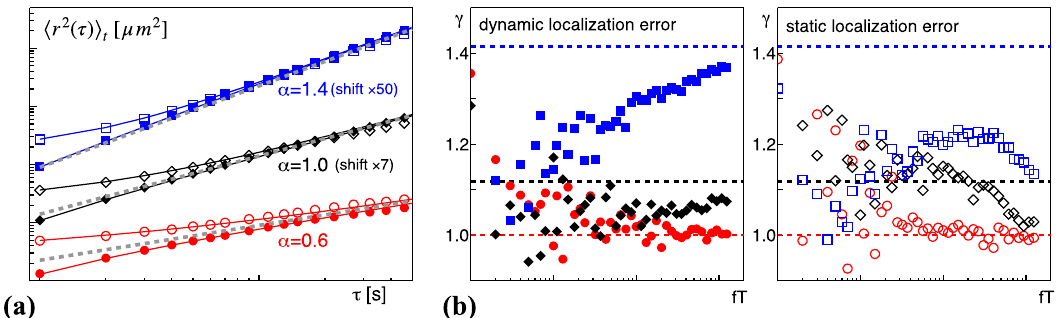
Fig. 2 Two-dimensional fractional Brownian motion (FBM) trajectories. We show the time-averaged mean squared displacements (TA-MSDs) and the coef fi cient of variation from Monte Carlo simulations of two-dimensional FBM trajectories in the presence of localisation noise. a Representative time- averaged mean squared displacements (TA-MSDs) of individual two-dimensional FBM trajectories created with H = 0.3 (red circles), H = 0.5 (black diamonds), and H = 0.7 (blue squares) follow the anticipated power-law scaling (grey dashed lines) for suf fi ciently long lag times τ . Ensemble averages of TA-MSDs are superimposed as coloured full lines. For short lag times, signi fi cant deviations due to a dominant dynamic localisation error ( n p = 900, fi lled symbols) or a dominant static localisation error ( n p = 50, open symbols) are visible. These may signi fi cantly perturb the extraction of the TA-MSD ’ s scaling exponent, α = 2 H . b The coef fi cient of variation γ , for the case of a dominant dynamic localisation error ( fi lled symbols) converges towards the predicted ffiffiffi p ffiffiffi p = 2 and values γ ¼ 1 ; 5 2 (highlighted by the coloured dashed lines). While the subdiffusive case (red) converges rapidly, normal diffusion and superdiffusion (black and blue, respectively) may need longer trajectories to eventually reach the predicted value. In contrast, for a dominant static localisation error (open symbols) only the subdiffusive case (red) is in agreement with the predicted value γ = 1 whereas normal diffusion and superdiffusion (black and blue) are very sensitive to this perturbation.